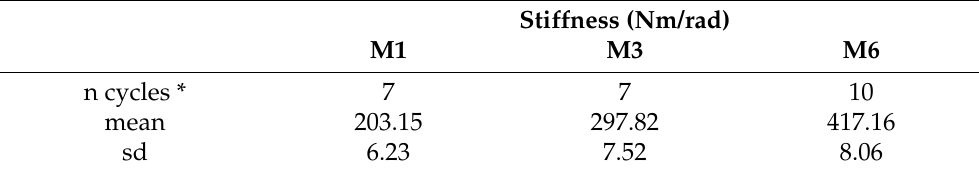
Table 2. Mean and sd of the ankle stiffness for each prosthetic